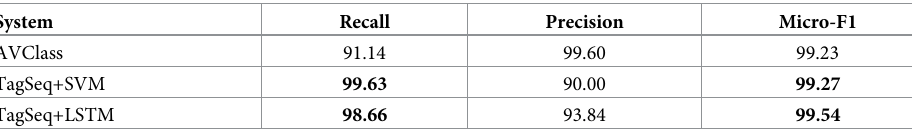
Table 7. Comparison with different